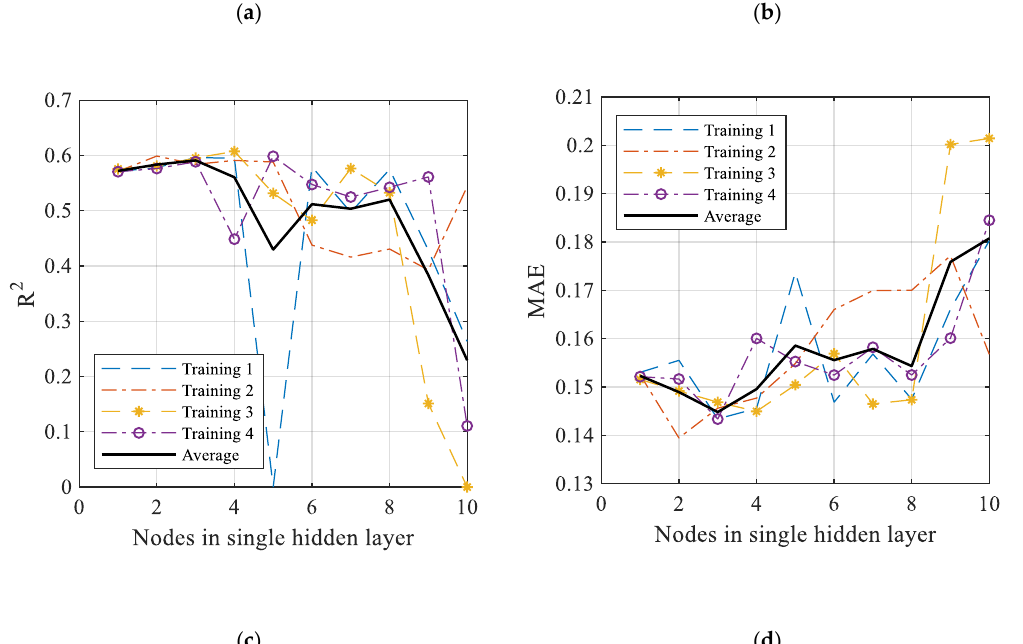
Figure 7. Optimization of the BPNN structure (40 feature values): ( a ) R 2 of validation set (one hidden layer); ( b ) mean absolute error (MAE) of validation set (one hidden layer); ( c ) R 2 of validation set (two hidden layers); ( d ) MAE of validation set (two hidden layers).